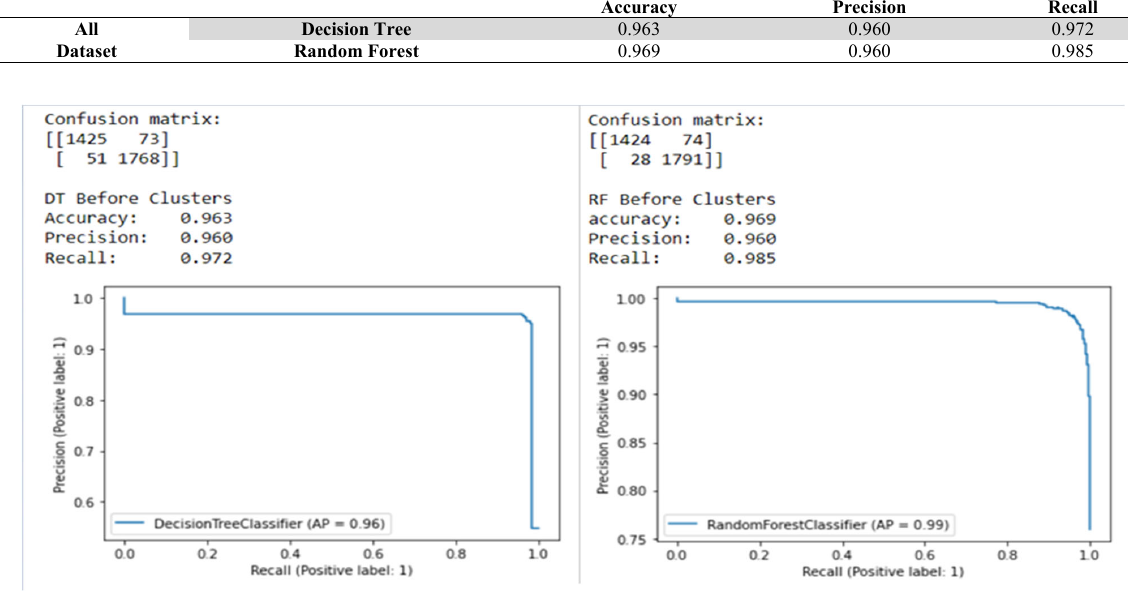
Fig. 11. Traditional classification results